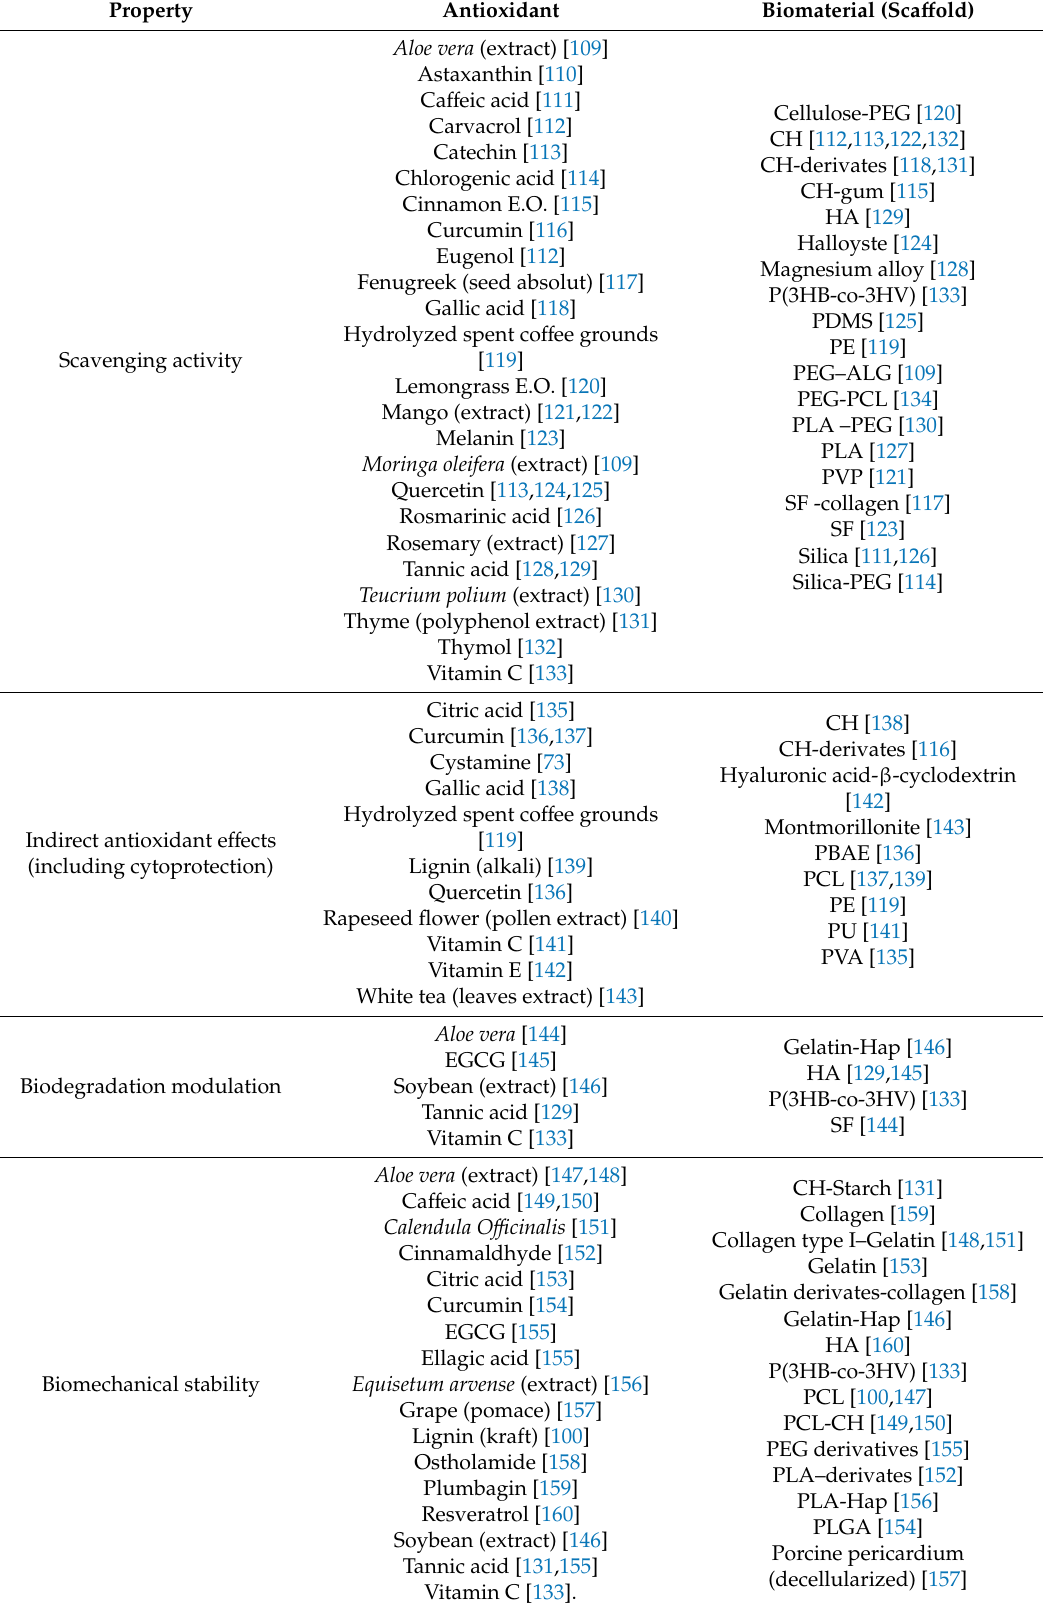
Table 1. Studies demonstrating the advantageous properties provided by the incorporation of specific natural antioxidants into various